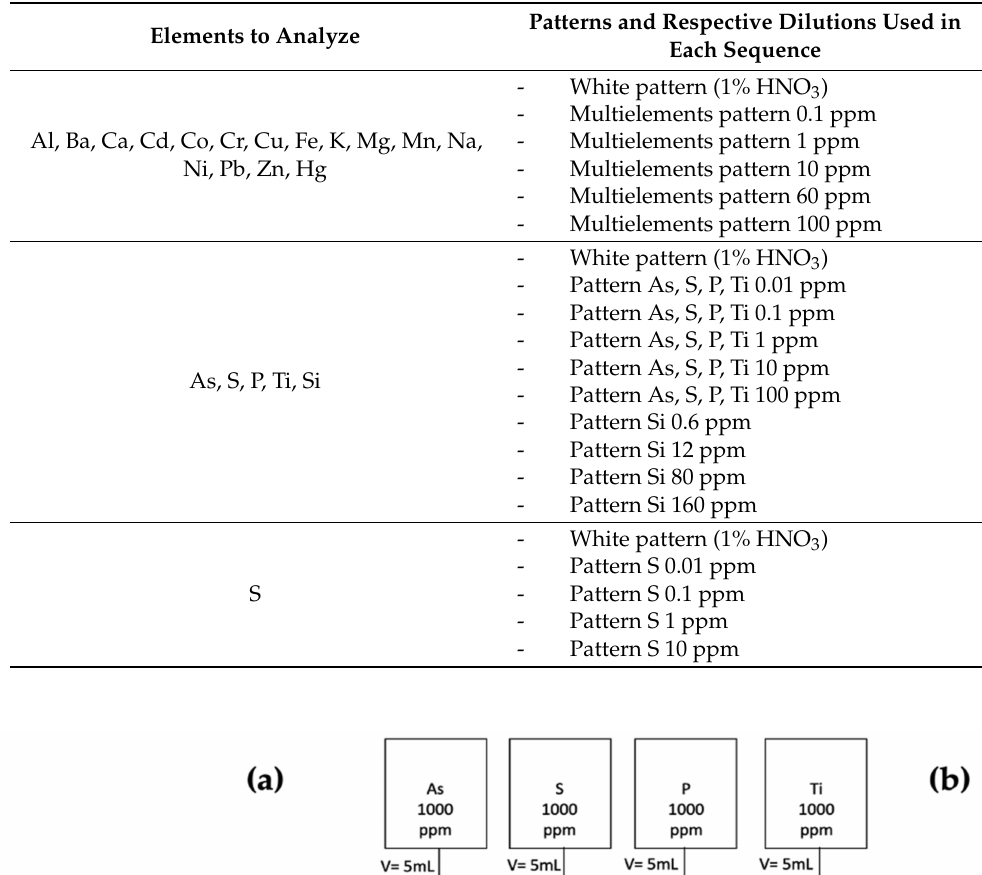
Table 1. Patterns used to the different sets of elements to be determined using ICP-OES.